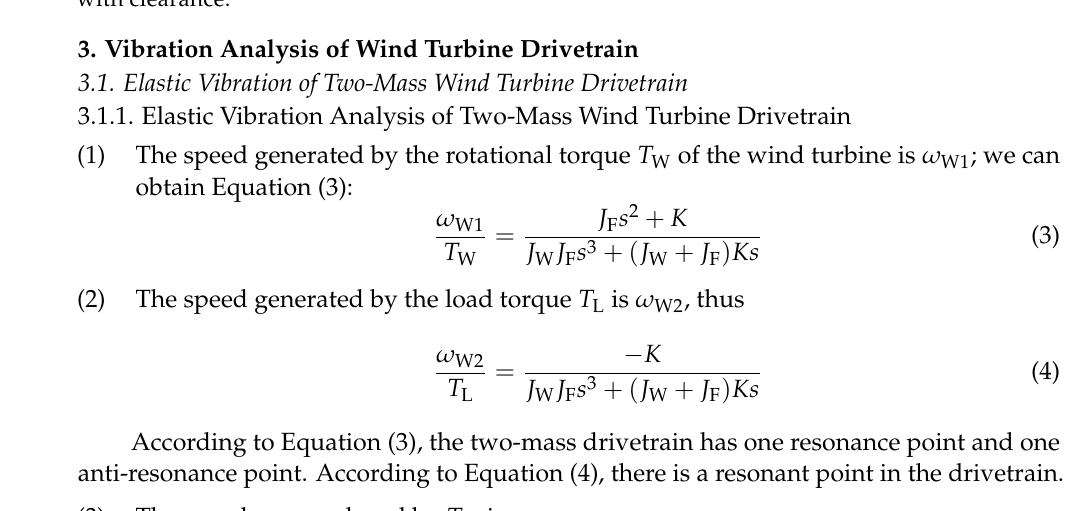
Figure 4. The transfer function structure diagram of the two-mass wind turbine drivetrain with